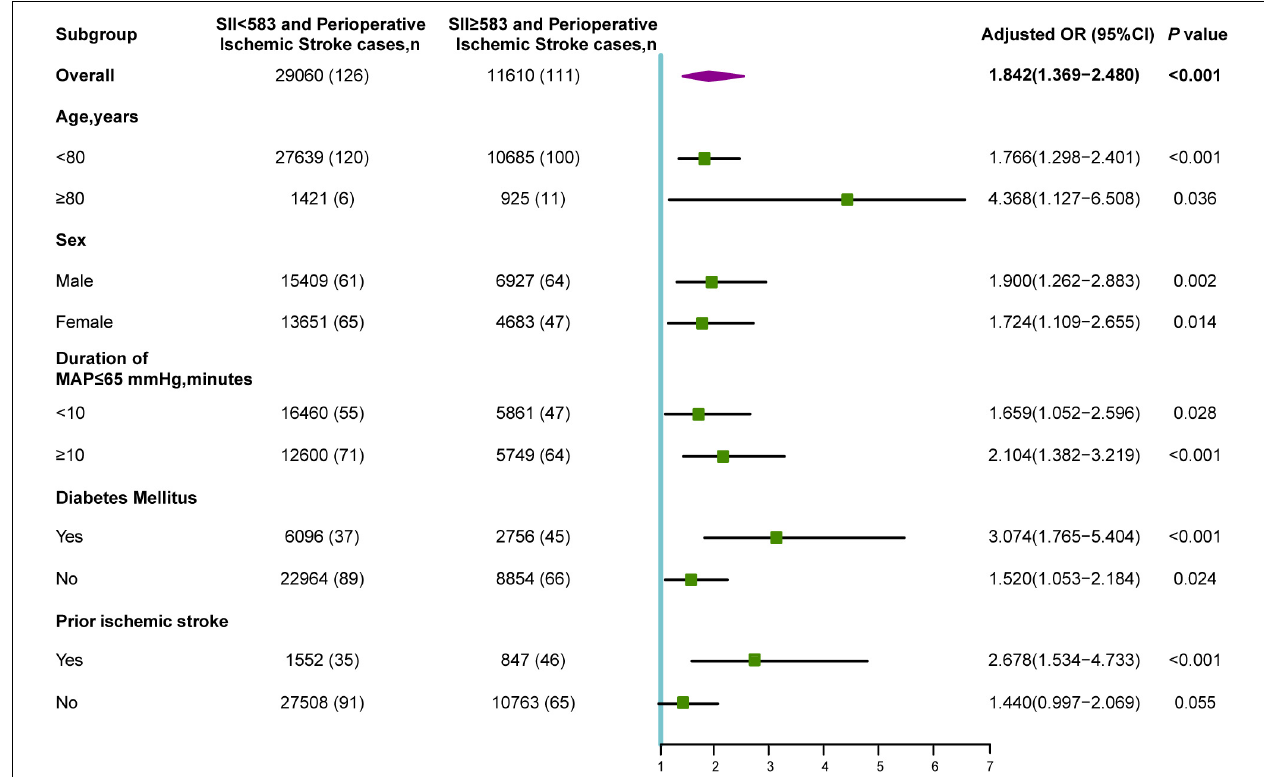
FIGURE 4 | Subgroup analyses of the association between SII and perioperative ischemic stroke. OR, odds ratio; MAP, mean arterial pressure.